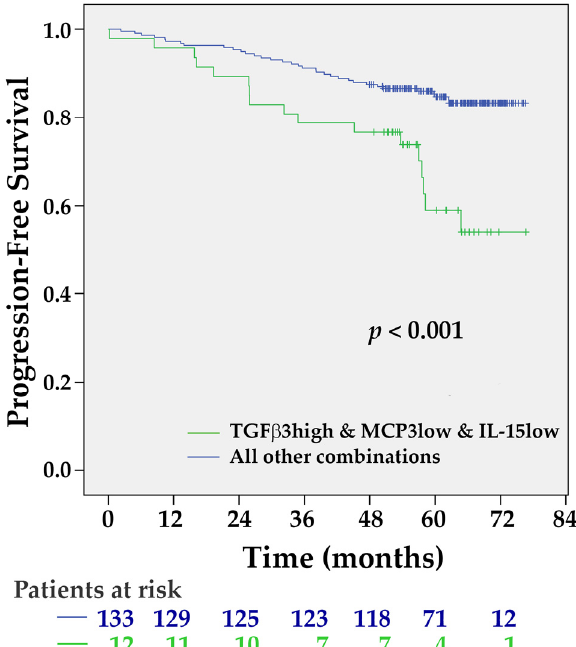
Figure 6. The Kaplan-Meier PFS estimates for the combination of TGF- β 3 high , MCP-3 low , and IL-15 low plasma levels. Patients with this combination of plasma cytokine levels had shorter PFS, p < 0.001 by the Log-rank test.